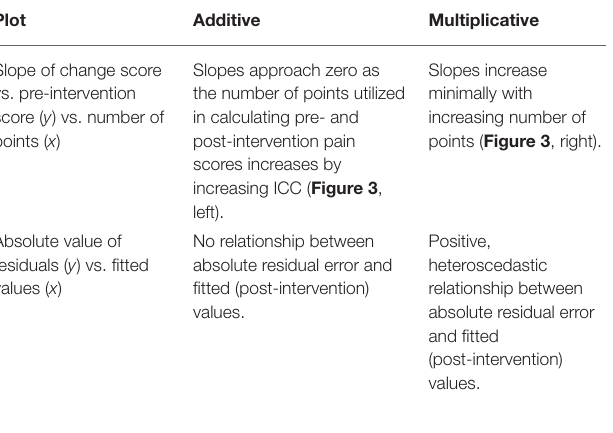
TABLE 2 | Hallmarks of additive and multiplicative effects. Plot Additive Multiplicative Slope of change score vs. pre-intervention score ( y ) vs. number of points ( x ) Absolute value of residuals ( y ) vs. fitted values ( x )